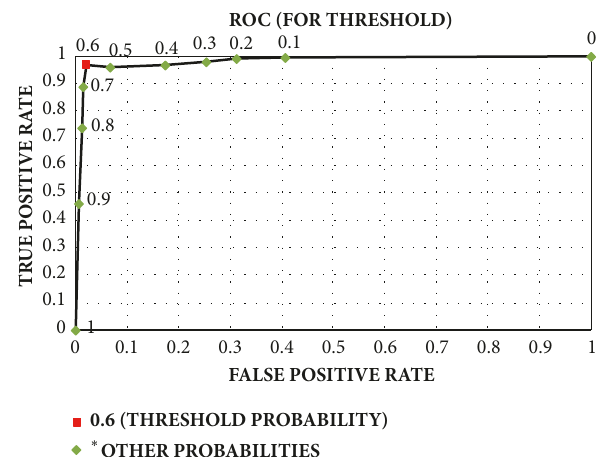
Figure 5: ROC for (explicit/nonexplicit) images predictions.